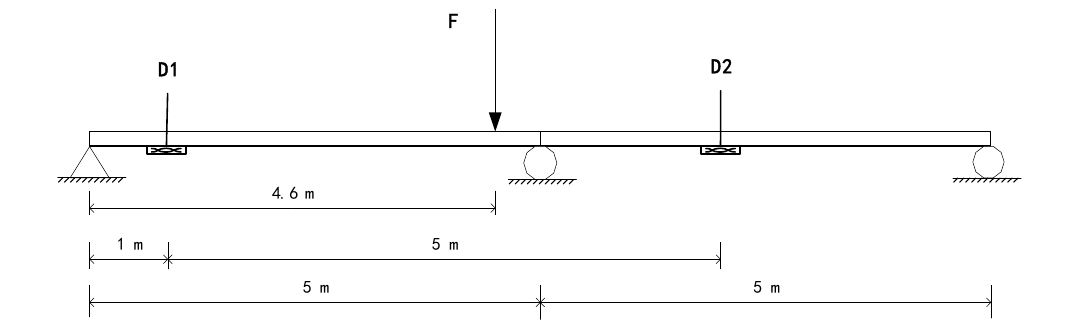
Figure 1. Continuous beam model.